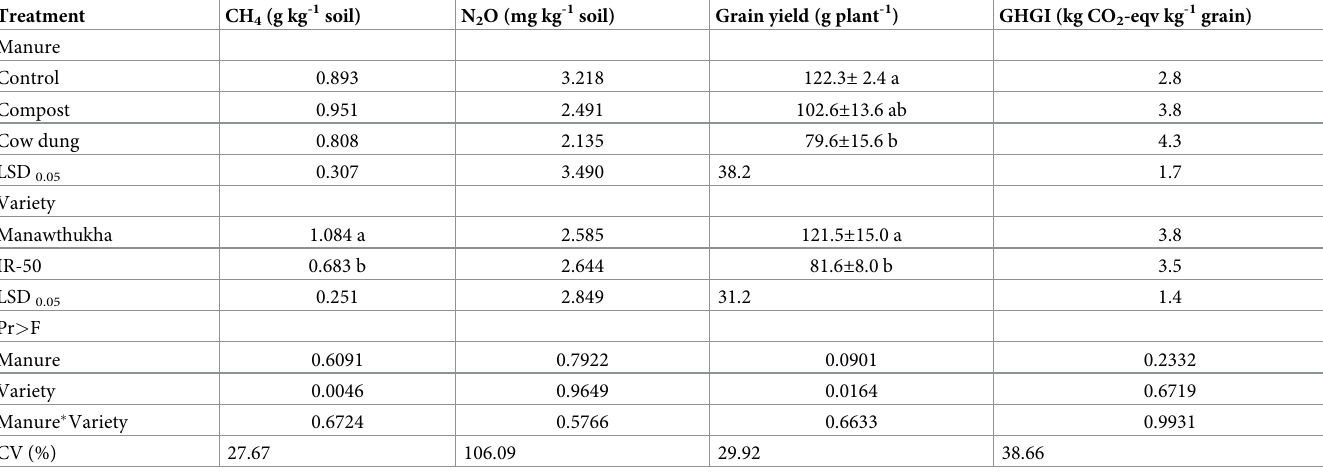
Within each column, values with different alphabets indicate significant differences among the treatments at 5% of LSD test.